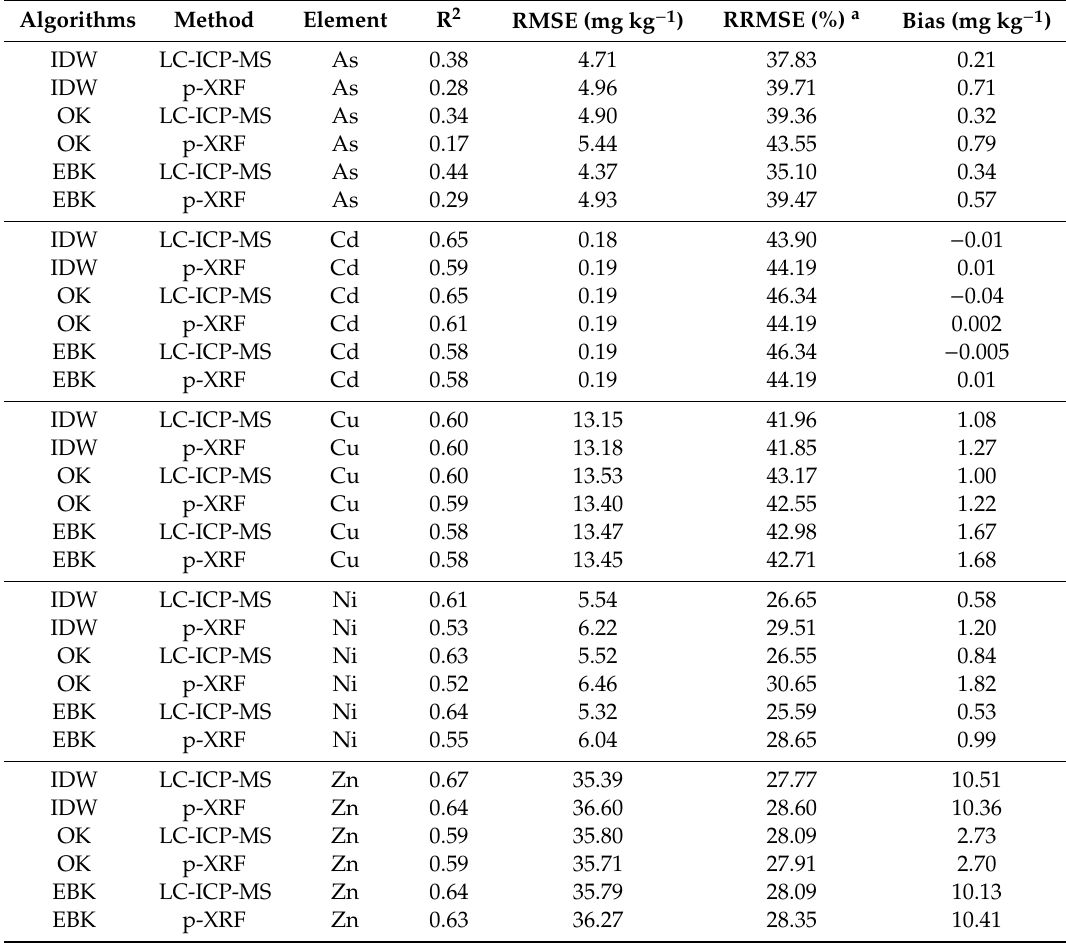
Table 3. Performance of di ff erent models using combined data evaluated by an independent validation